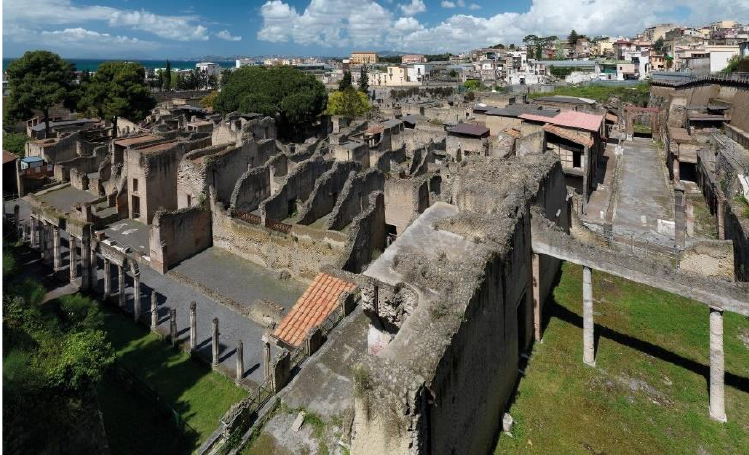
Figure 3. View of Herculaneum Archaeological Park with actual city and gulf of Naples in the back [31].